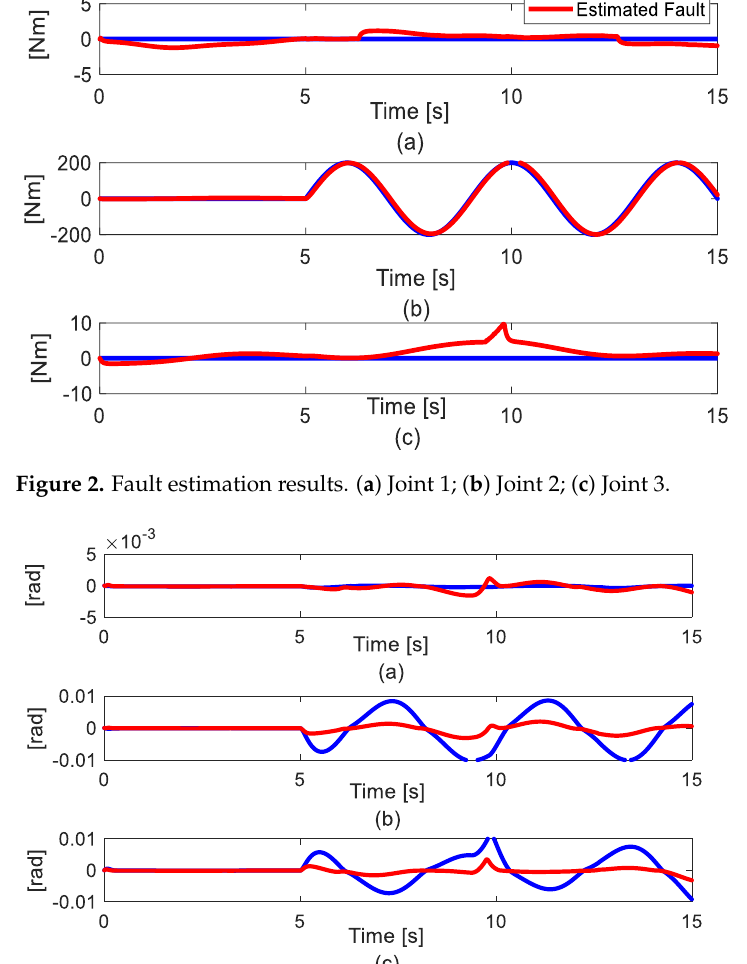
Figure 4. Fault estimation results. ( a ) Joint 1; ( b ) Joint 2; ( c ) Joint (3).